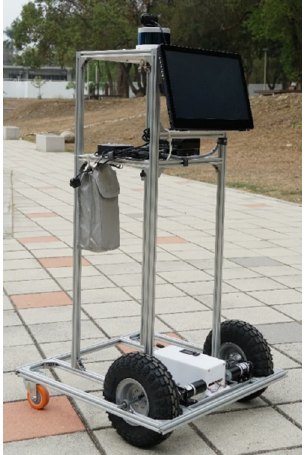
Figure 22. Remotely controlled mobile carrier. Table 3. Jetson AGX tests for each power